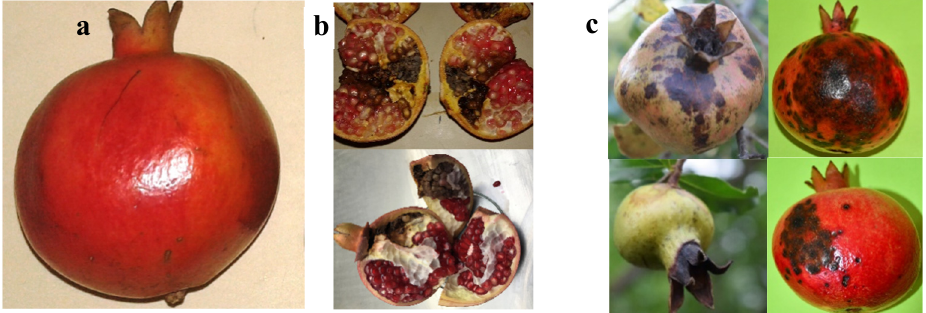
Figure 1. Fruits showing characteristic symptoms of heart rot caused by Alternaria ( a , b ) and Calyx rot/fruit rot caused by Colletotrichum ( c ).